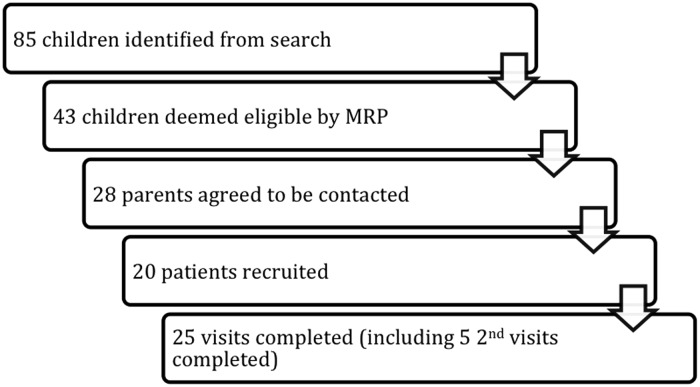
Study participation.